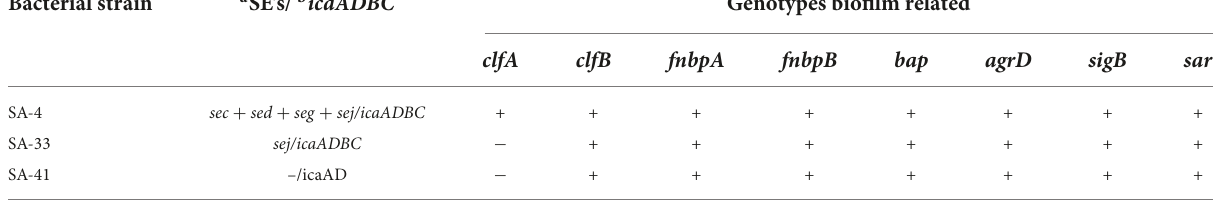
TABLE 2 Characteristics associated with biofilm formation of Staphylococcus aureus in this study. Bacterial